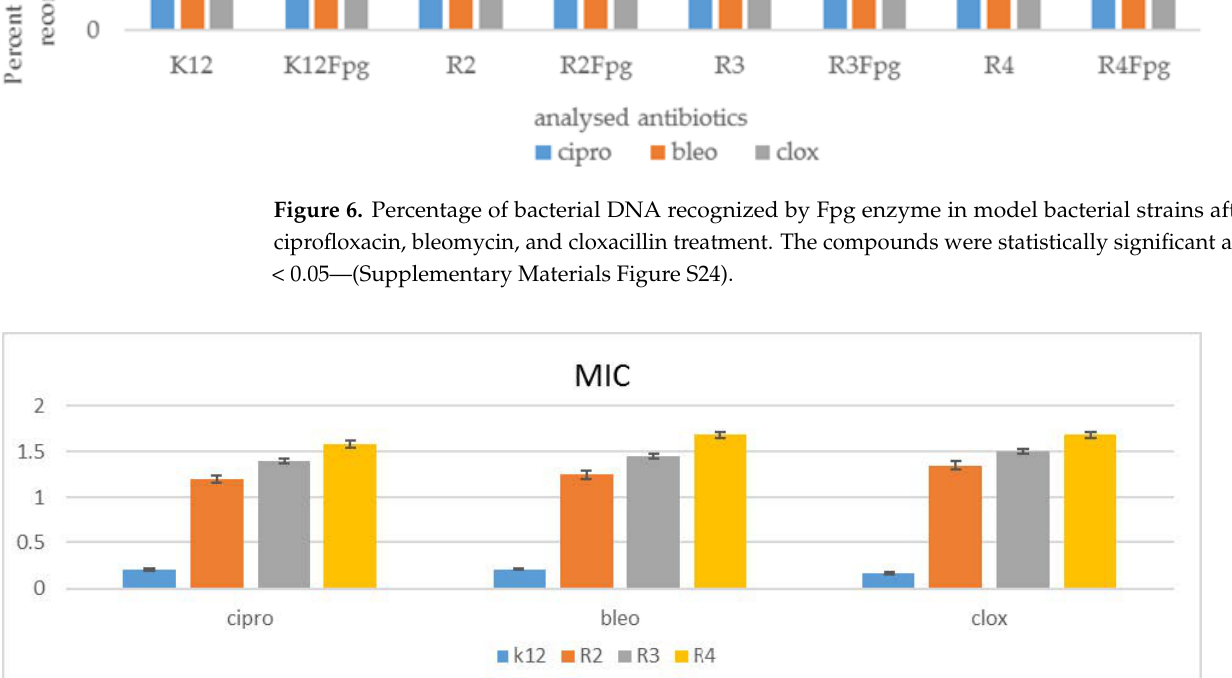
Figure 7. Examples of MIC with model bacterial strains K12, R2, R3, and R4 for studying antibiotics ciprofloxacin (cipro), bleomycin (bleo), and cloxacillin (clox). The x -axis features antibiotics used sequentially. The y -axis features the MIC value in µg/mL. The order in which the compounds were applied to the plate are shown in Supplementary Materials Figure S22.